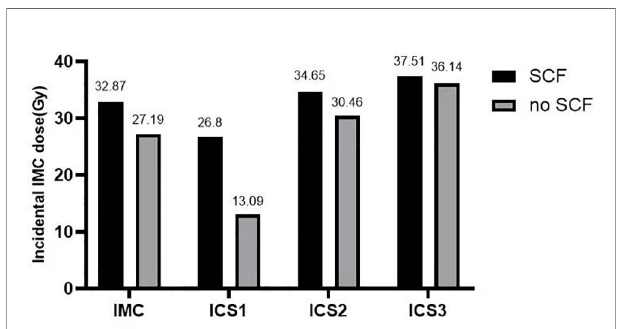
FIGURE 1 | Histogram: mean incidental dose to the IMC and the fi rst to third intercostal spaces of the IMC. The dose delivered to the IMC and the fi rst two ICSs showed greater coverage in patients with SCF irradiation ( P = 0.001, 0.000, 0.011). IMC, internal mammary chain; SCF, supraclavicular fossa;